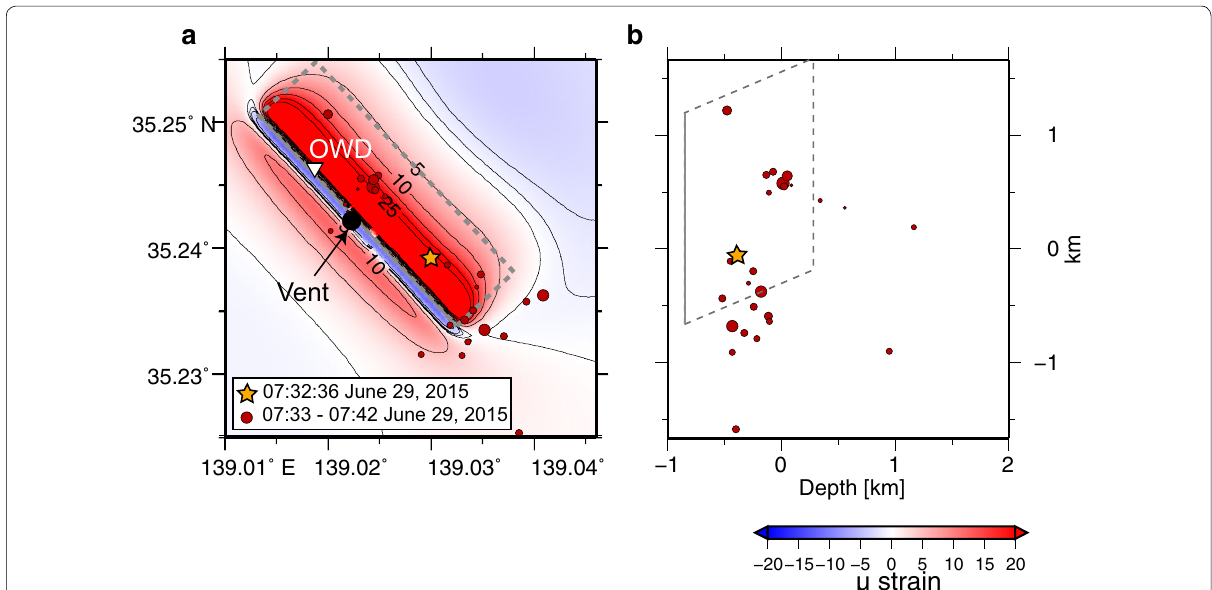
Fig. 4 Volumetric strain changes resulting from the crack opening. a Map view of the volumetric strain change at an elevation of 1000 m around the Owakudani region. A star and the red circles show the first and subsequent VT events, respectively, during the 10 min after the onset of the rapid tilt change, as estimated by Yukutake et al. (2017). b Depth distribution of the VT events along a N–S